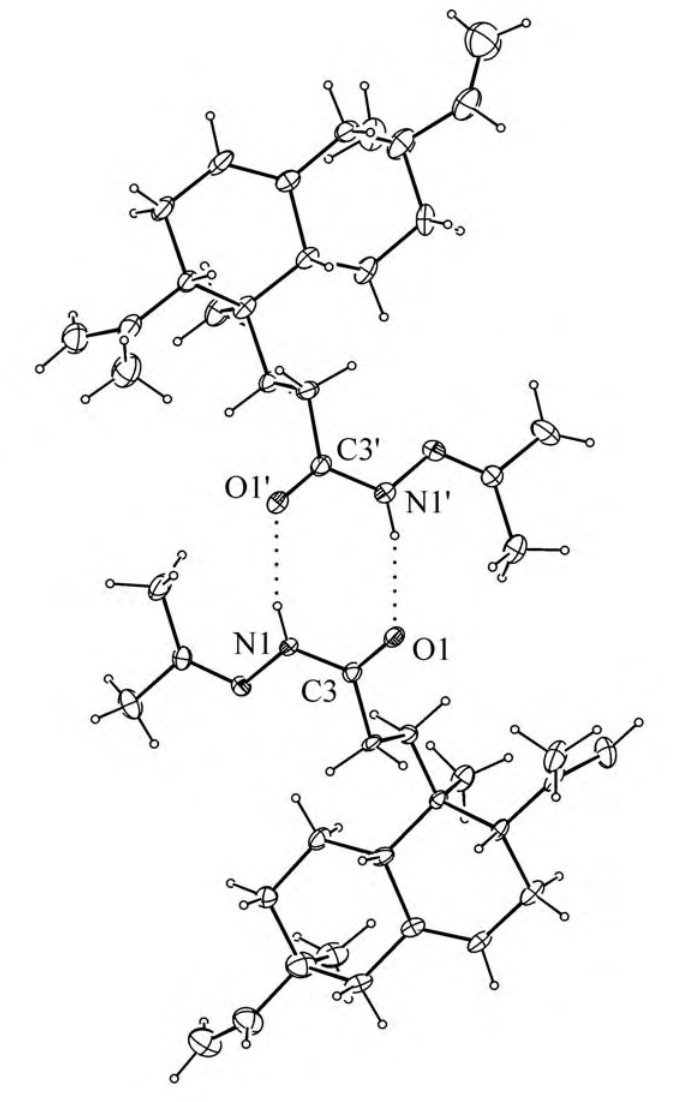
Figure 2. A perspective view of the two independent molecules of 4 . Dotted lines indicate the two intermolecular hydrogen